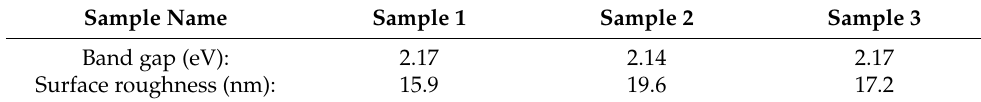
Table 5. Investigated (SE) parameters of Cu 2 O:N thin films [76,77].